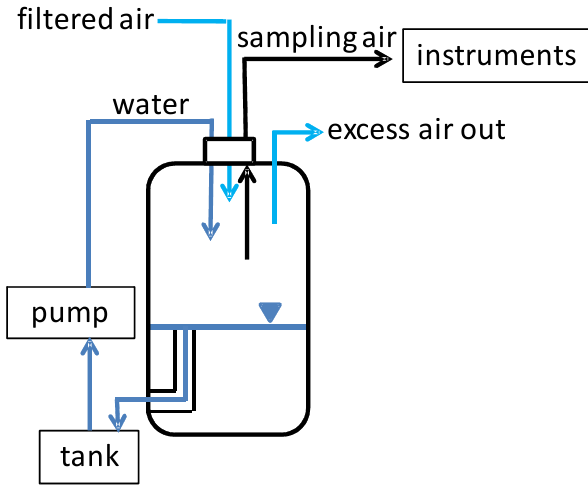
Fig. 1. Schematic picture of bubble bursting experimental setup. The tank was used as a buffer to recirculate the sea water sample trough the PET bottle, where primary marine aerosols were pro- duced by an impinging water jet. Darker blue lines represent water, and the triangle symbol indicates the water surface in the